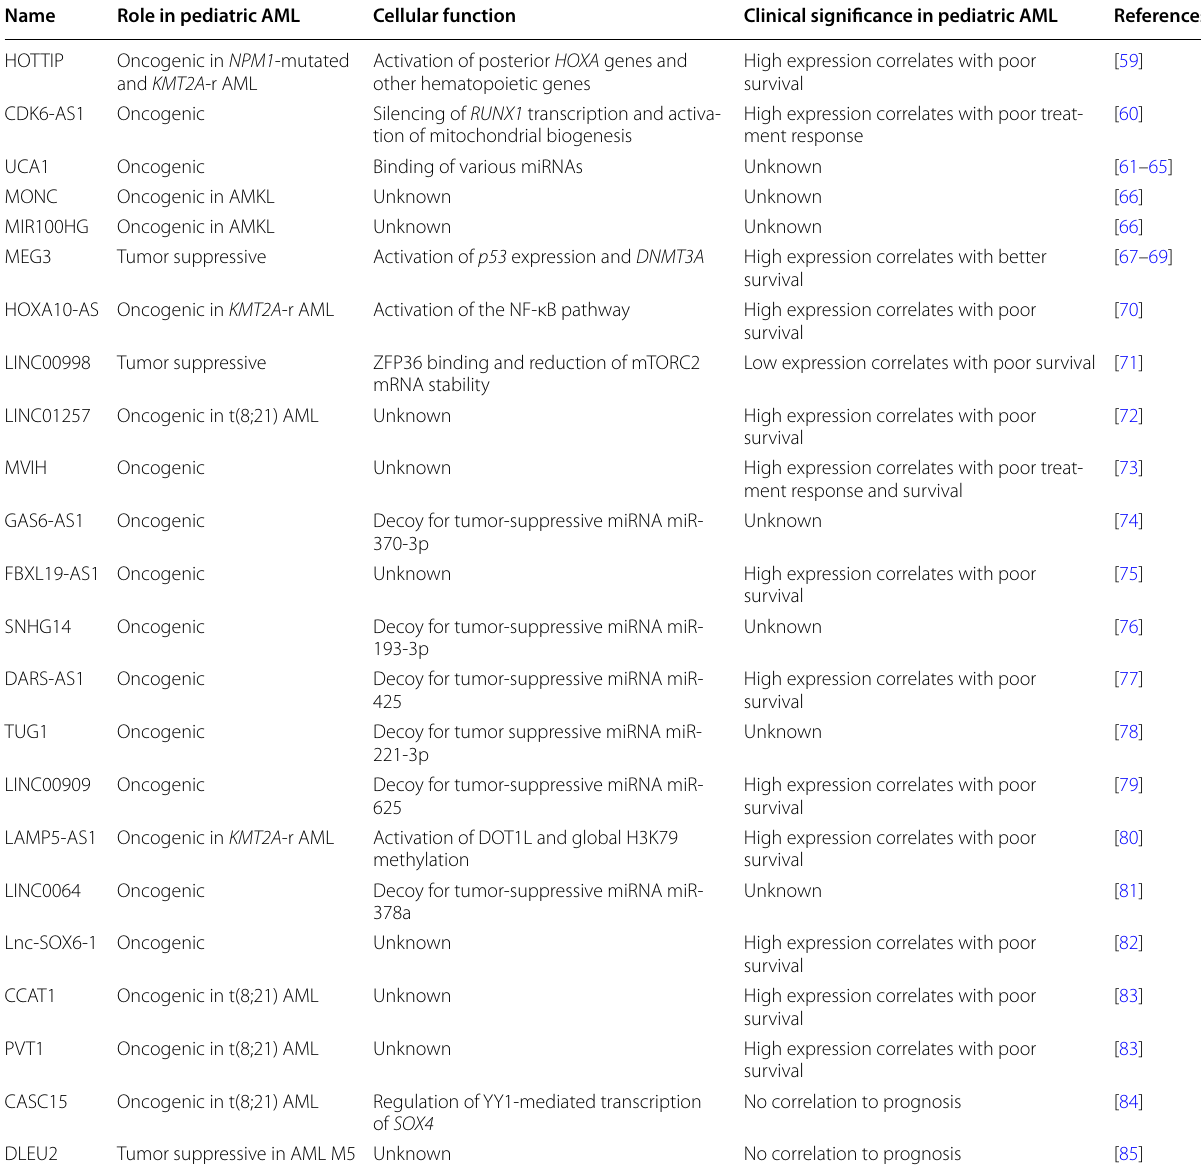
Table 1 LncRNAs implicated in pediatric acute myeloid